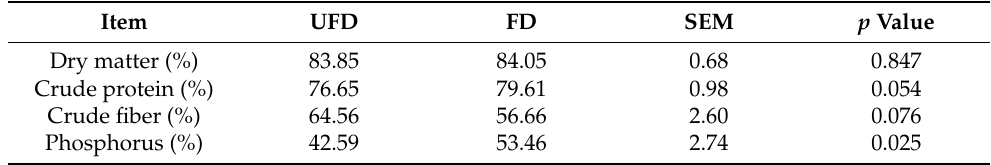
Table 4. Effect of dietary supplementation with FFS on the apparent nutrient digestibility in weaned